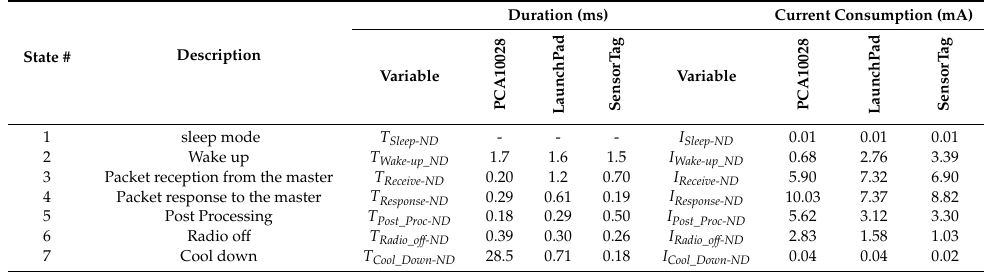
Table 1. State characterization of a connection interval without data